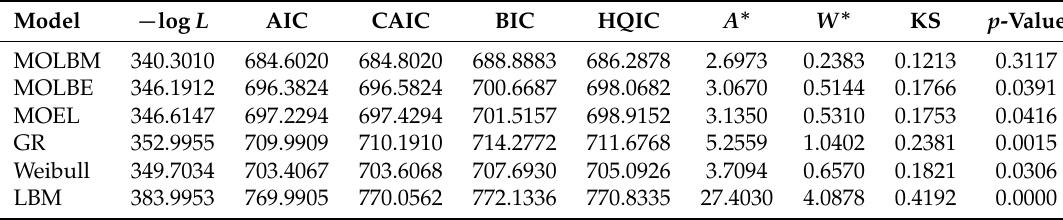
Table 16. Some criteria and goodness of fit measures for Data set 5.